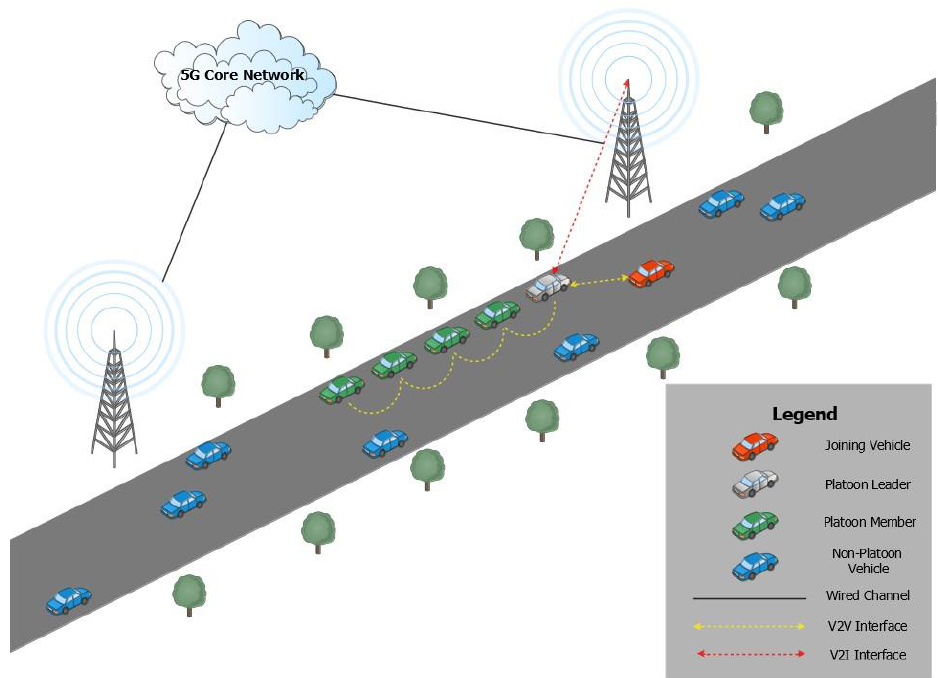
Figure 1. System